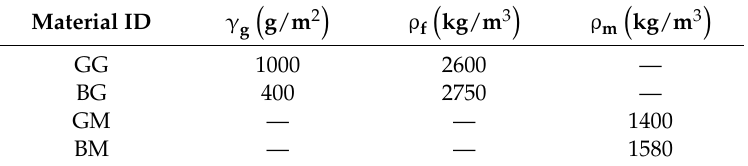
Table 10. Grid mass and fibre density.